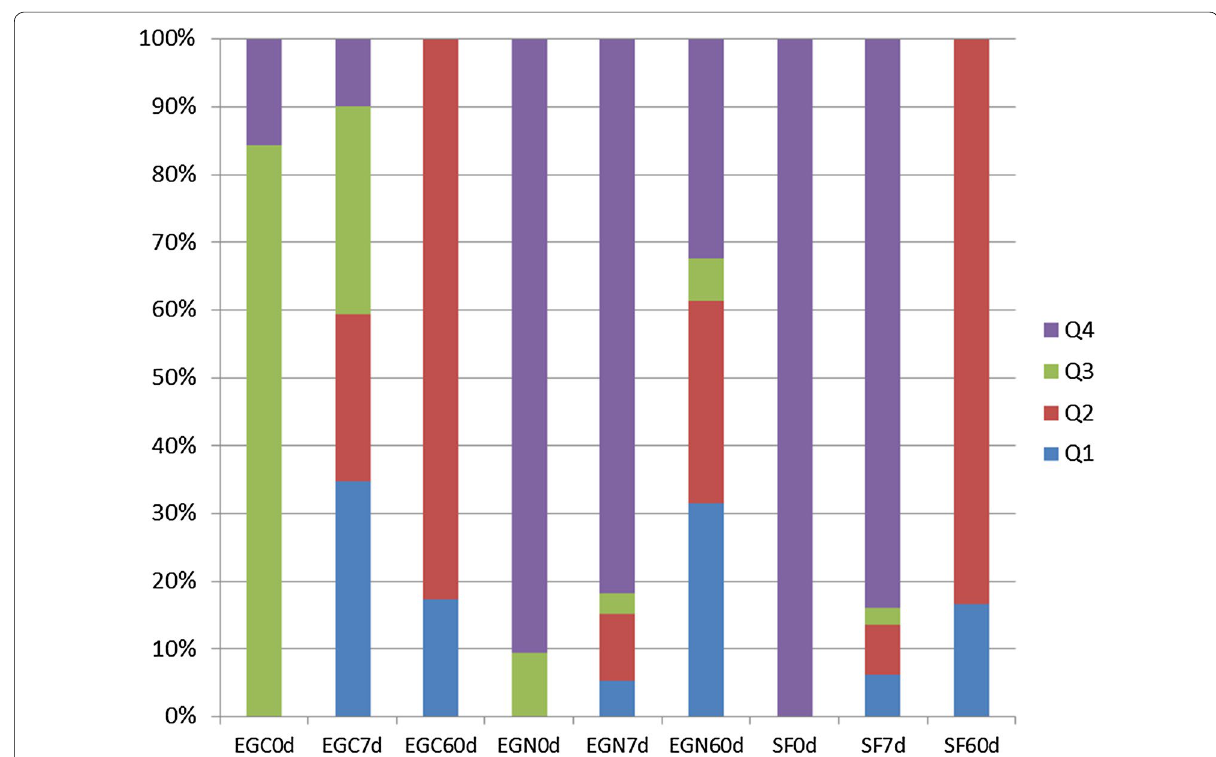
Fig. 5 Percentage of Q n units in the starting materials and 7‑ and 60‑day